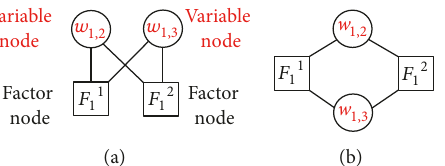
Figure 2: Two representations of the factor graph: bipartite graph (a) and cyclic graph (b). The factor graph contains a cycle. The connection of factor node 𝐹 1 1 to variable nodes 𝑤 1,2 and 𝑤 1,3 denotes the dependence of 𝐹 1 1 on 𝑤 1,2 and 𝑤 1,3 since 𝐹 1 1 is a function of 𝑤 1,2 and 𝑤 1,3 .